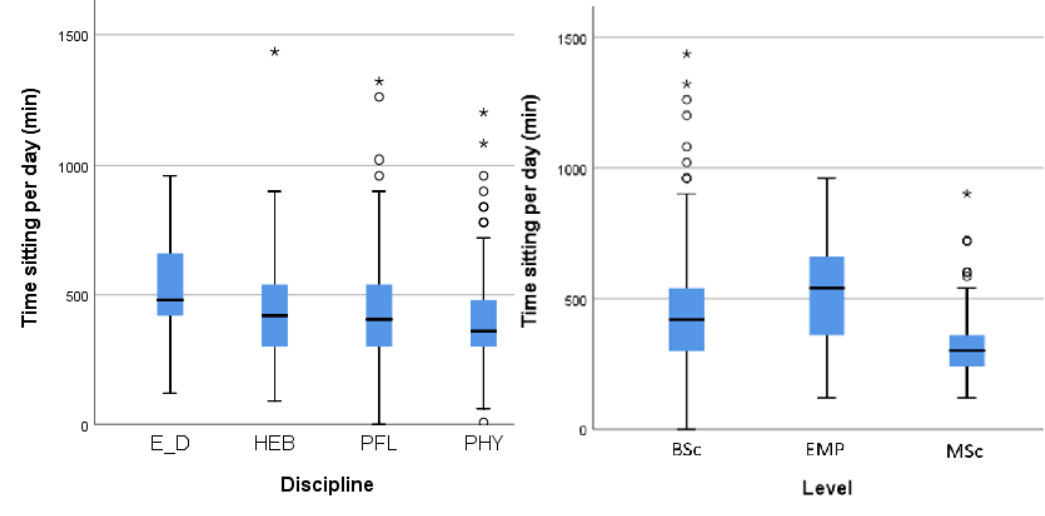
Figure 3. Box plots showing the daily sitting times (in minutes) among students and employees (n=761) from four divisions of a Swiss university of applied sciences during the spring 2020 COVID-19 lockdown. Left: daily sitting times per health profession division. Right: daily sitting times per group of students and employees. Whiskers indicate 1.5 × IQR unless truncated at the lowest score. Asterisks and circles represent values outside this range. BSc: Bachelor of Science students; E_D: nutrition and dietetics; EMP: employees; HEB: midwifery; MSc: Master of Science students; PFL: nursing; PHY: